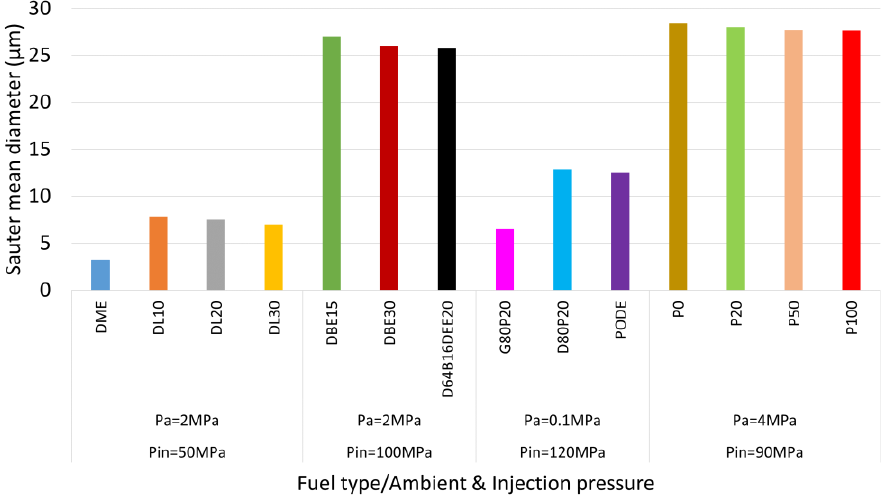
Figure 9. SMD for various ether-based additives (such as DBE, PODE) with diesel at different injection & ambient pressures [30,42,74,75,78].